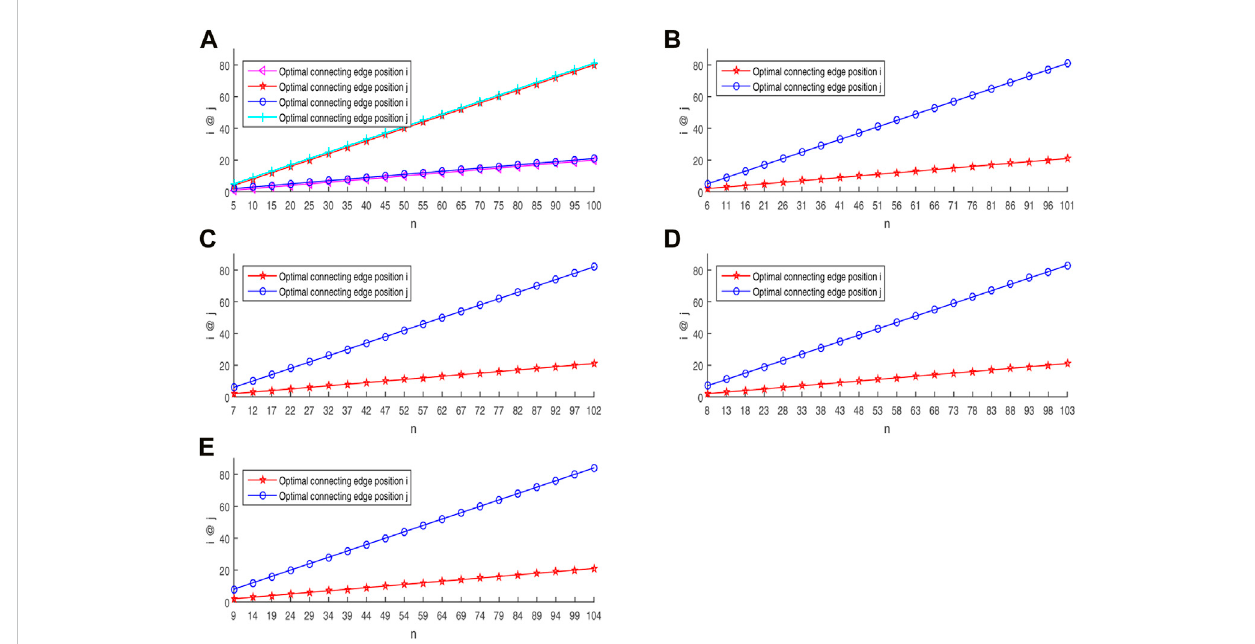
The optimal edge connection positionsi and j vary with the number of single-layer network nodes n. (A) n = 5 k ; (B) n = 5 k + 1; (C) n = 5 k + 2; (D) n = 5 k + 3; (E) n = 5 k +